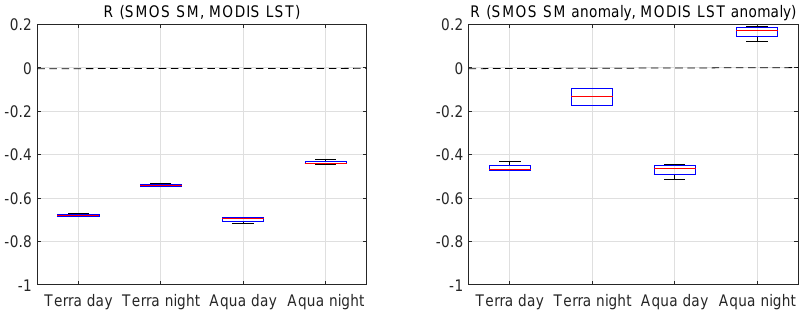
Figure 6. Correlation (R) of SMOS SM at the morning passes and MODIS LST ( left ) and their anomalies ( right ) for different MODIS platforms and passes: (i) Terra day; (ii) Terra night; (ii) Aqua day; and (iv) Aqua night. Similar behavior is obtained at the afternoon passes (not